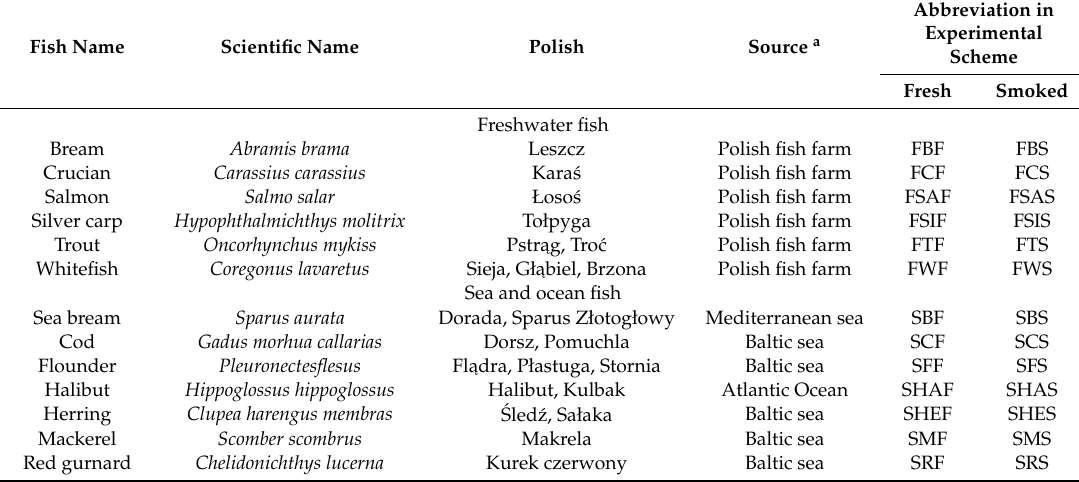
Table 1. Scientific and common name of experimental fish and abbreviations in the experimental